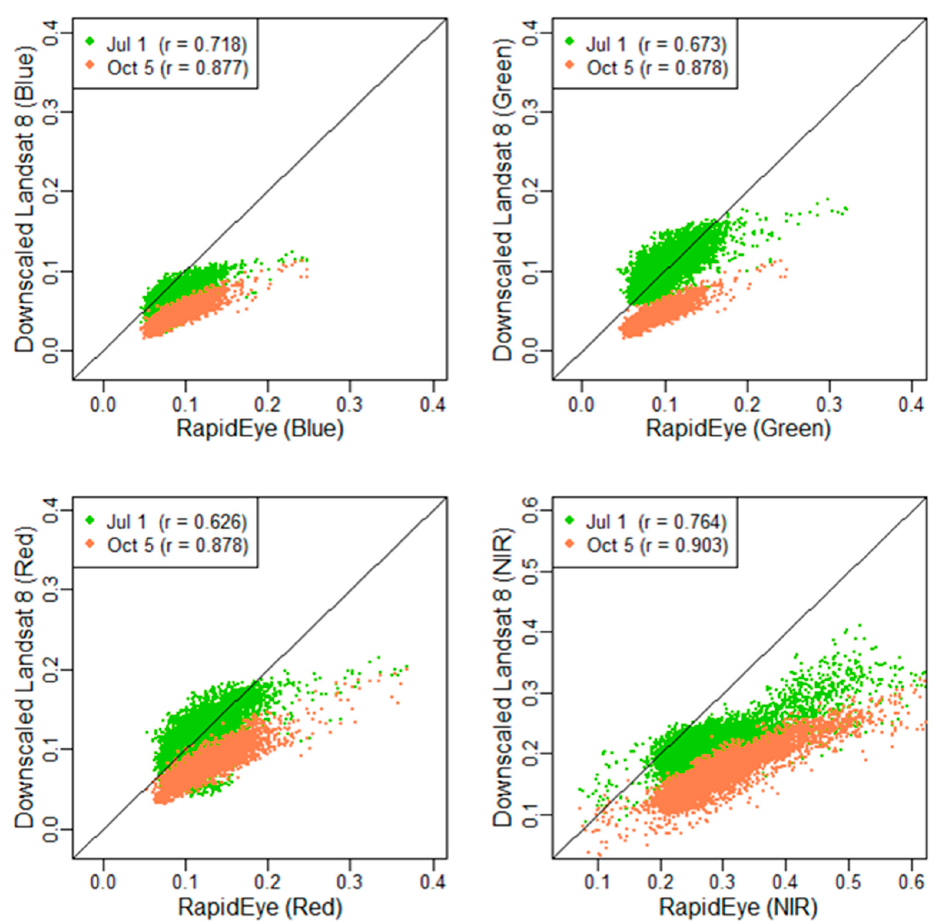
Figure 7. Scatter plots of RapidEye reflectance vs. downscaled Landsat reflectance. The correlation coefficient between the values of RapidEye and downscaled Landsat are shown in the r value.